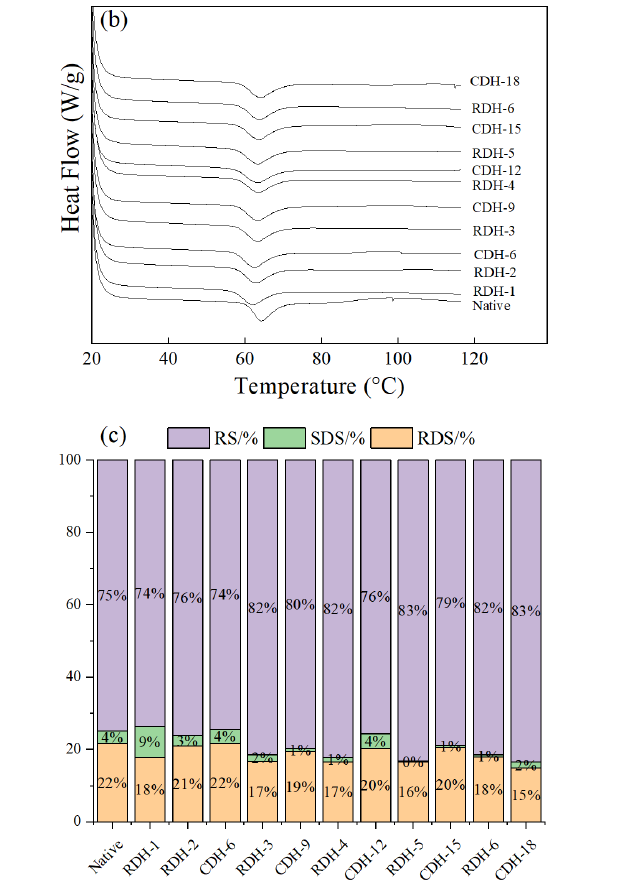
Figure 3. Pasting properties ( a ), DSC thermograms ( b ) and RDS, SDS and RS ( c ) of the native, CDH- and RDH-treated potato starch samples.